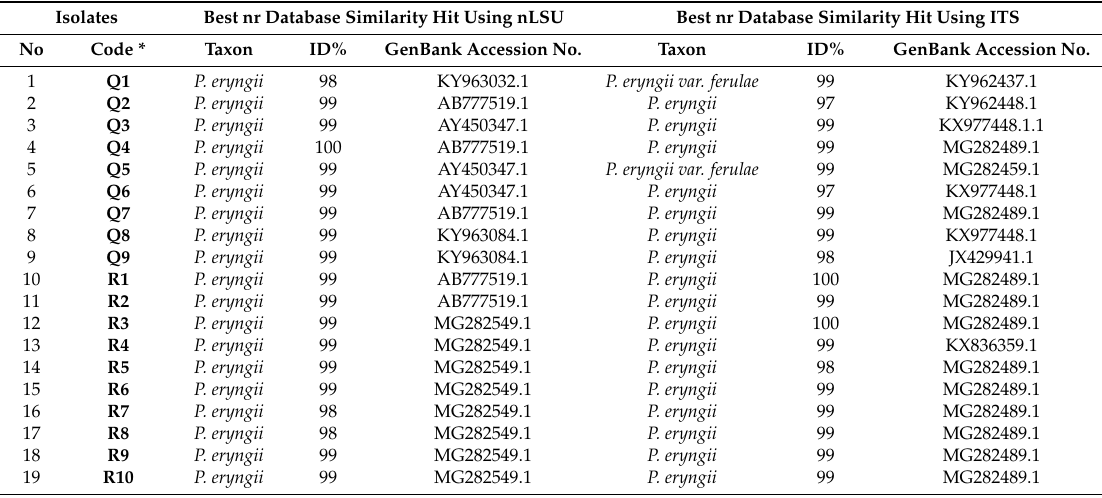
Table 2. Molecular identification of 19 Jordanian Pleurotus isolates using internal transcribed spacer (ITS) and nuclear large subunit (nLSU) rRNA sequence